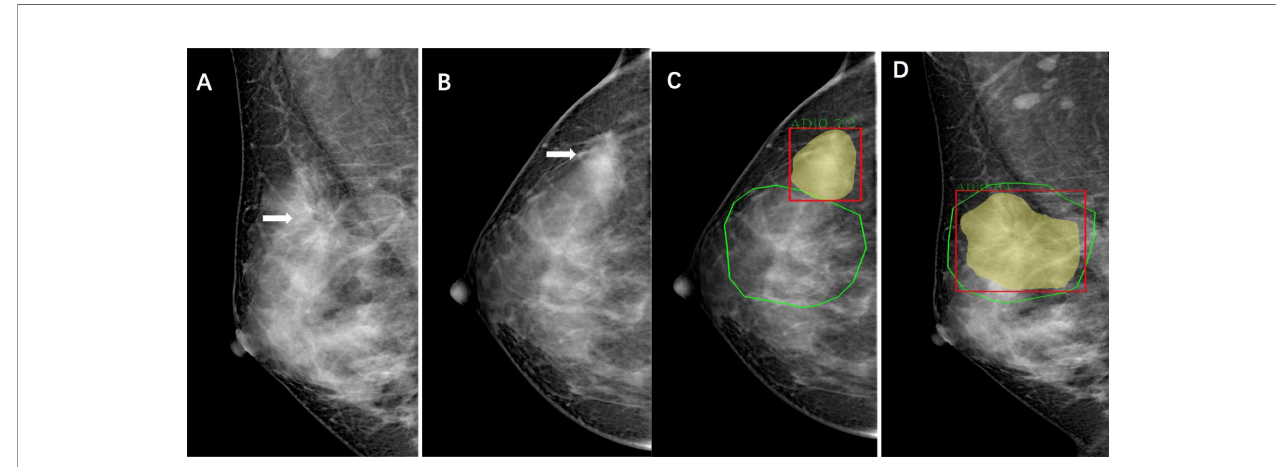
FIGURE 1 | Images of a 44-year-old woman with architectural distortion who presented for clinical mammography. (A) Right mediolateral oblique mammogram shows malignant architectural distortion (arrow) in the upper outer quadrant. (B) , Right craniocaudal mammogram shows an AD (arrow) with increased gland density. (C, D) Green outlined areas were manually delineated for architectural distortion on mammography by radiologists using ITK-Snap software. Yellow and read outlined areas and scores are shown as observed in the viewer of the AI